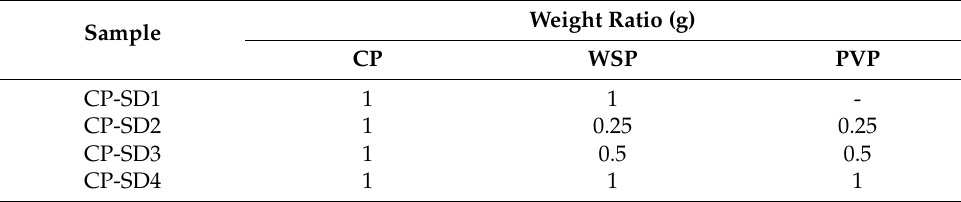
Figure 2. XRD patterns of CP-SD in comparison with different drug-carrier ratios and raw materials of CP and carriers. Table 1. Composition of CP-SD.